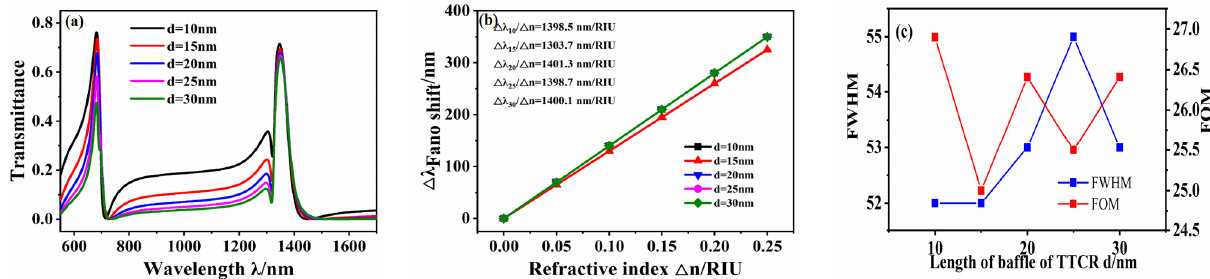
Figure 7. ( a ) Transmission spectrum of waveguide structure under different d . ( b ) Sensitivity fitting curve. ( c ) Fitting curve of FWHM and FOM values.